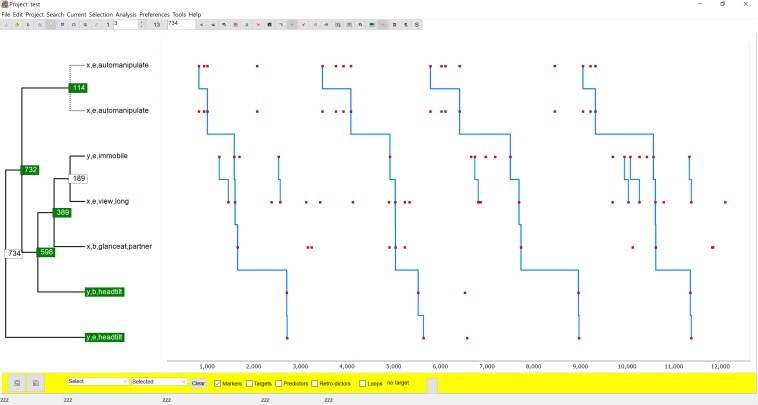
This figure shows a T-pattern different from Figure 3 but detected in the same T-data showing strong relations between the behaviors of each child related to the transfer of the toy. It is characteristic of girl x that when she is waiting to get the toy again, she repeatedly fiddles with something, easily perceived as a sign of impatience. Freezing (immobile) only occurs in y and only when she is waiting for the toy. Finally, the head tilt, often associated with begging, only occurs in y and then only when she is waiting.